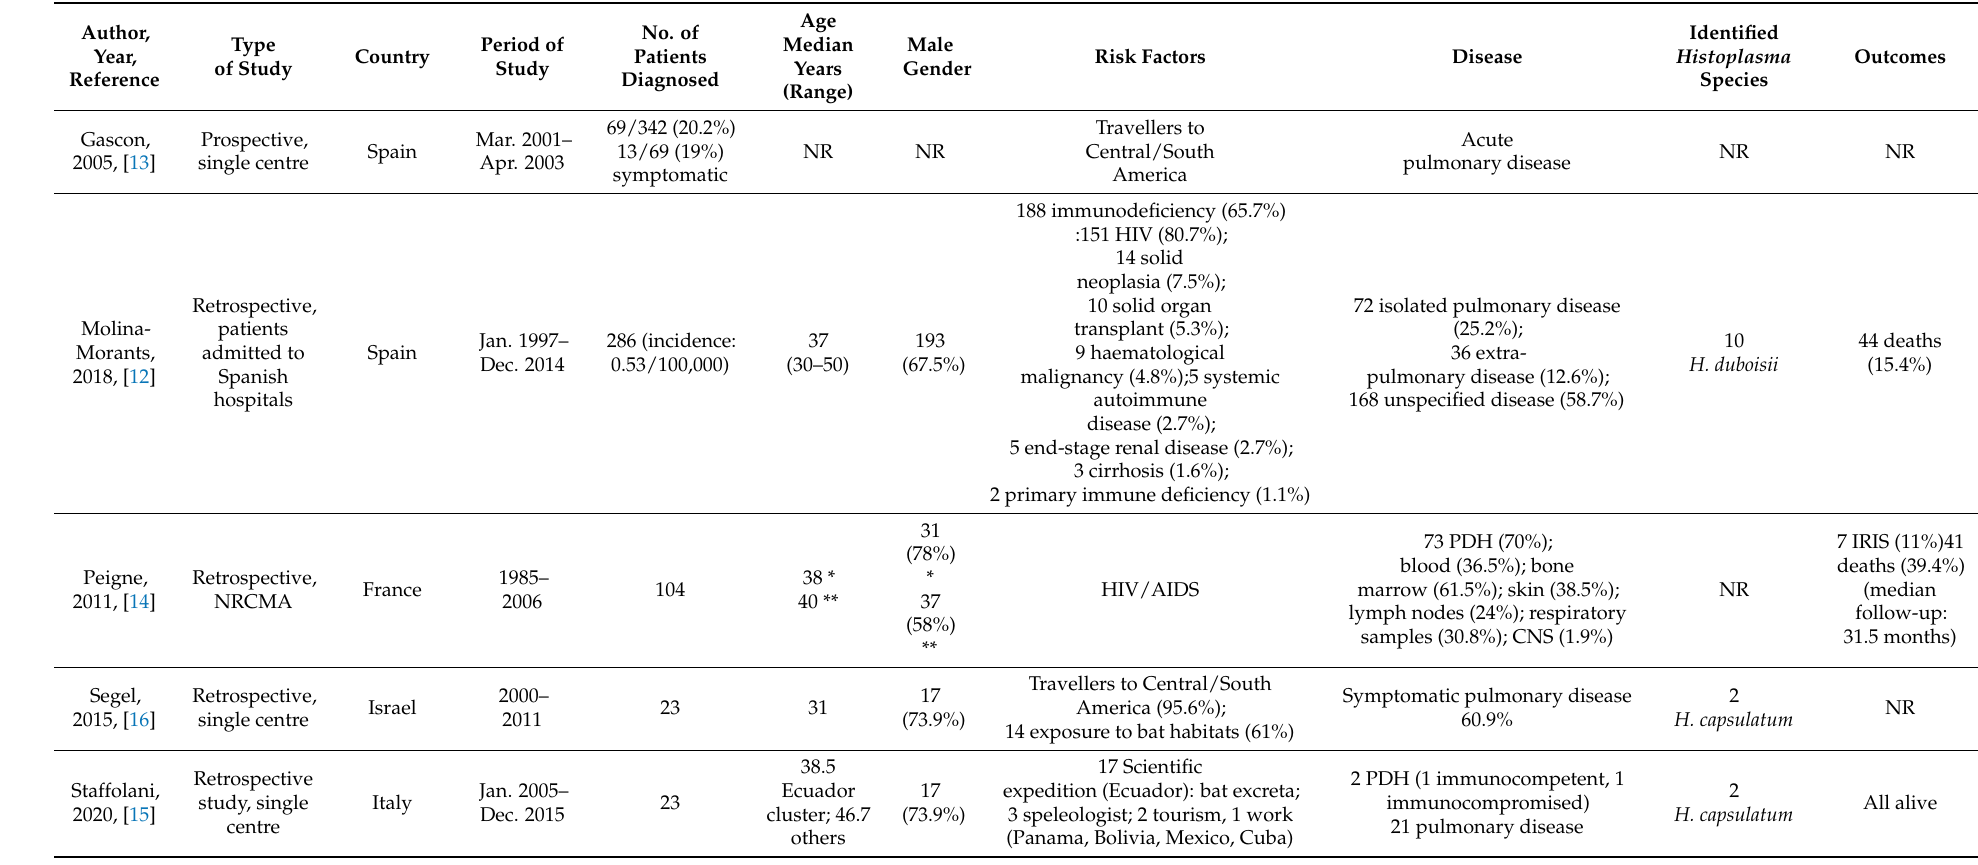
Table 1. Studies describing 505 cases of histoplasmosis in Europe and Israel between 2005 and